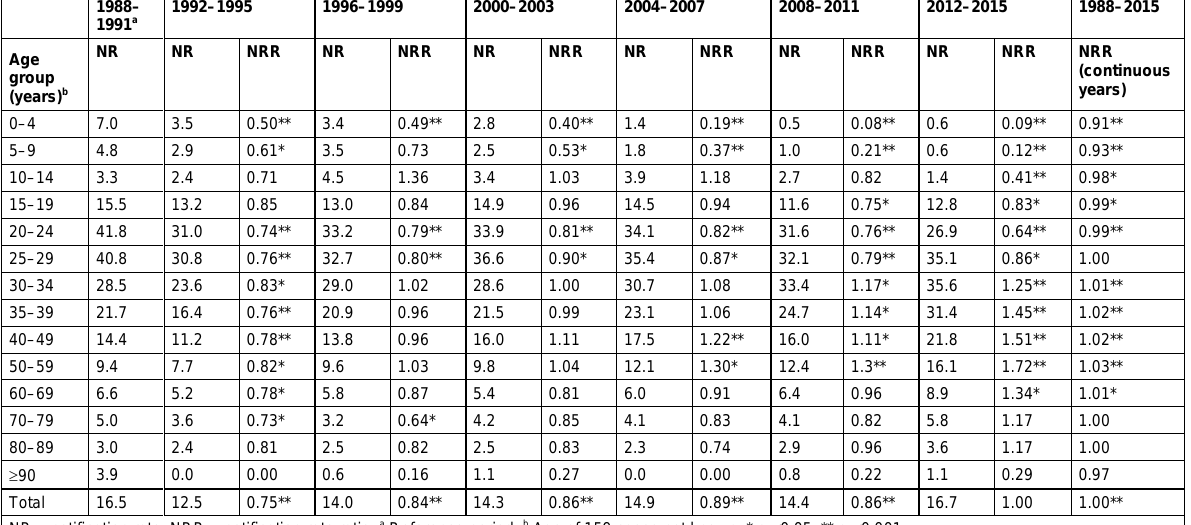
Table 4: Development of the notification rate of chronic hepatitis B virus infection per 100 000 population by age, Switzerland,